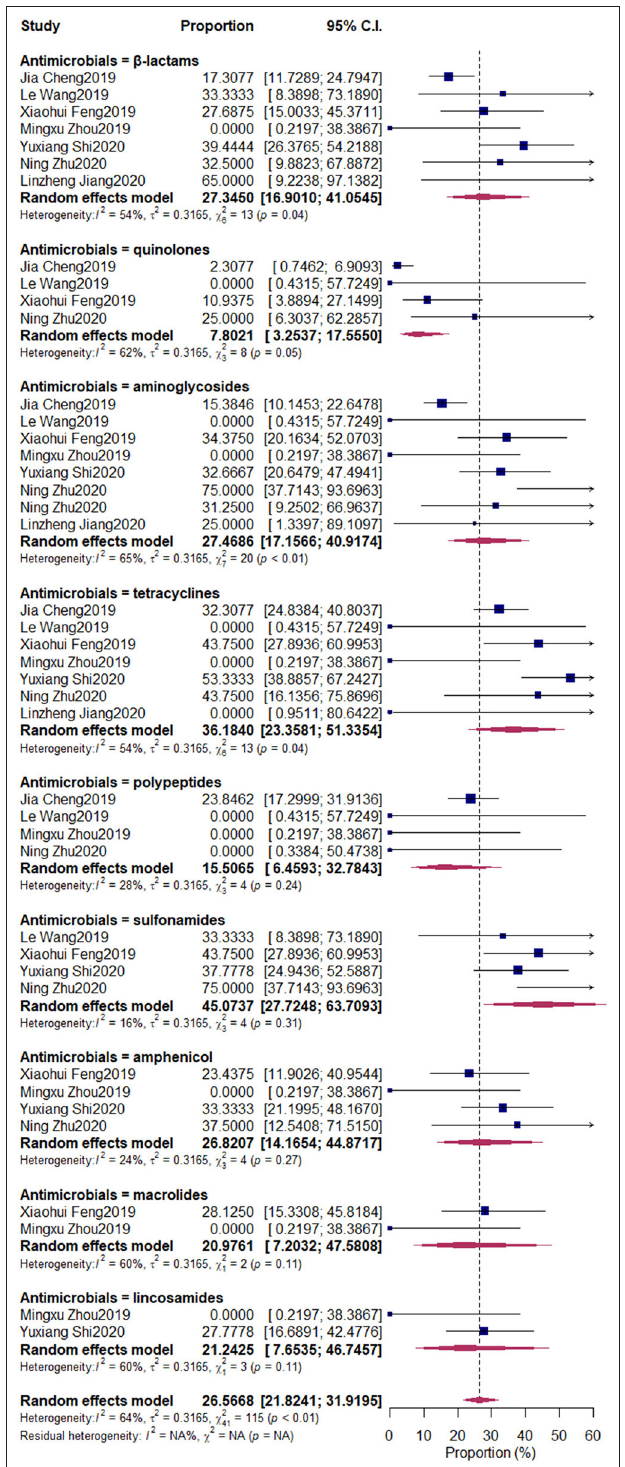
FIGURE 7 | Antimicrobial-resistant rate of Klebsiella spp. Subgroups were created according to the different kinds of antimicrobials. The nine upper diamonds represent the overall antimicrobial resistance (AMR) rate within the respective subgroups, whereas the diamond at the bottom represents the overall AMR rate of all studies.